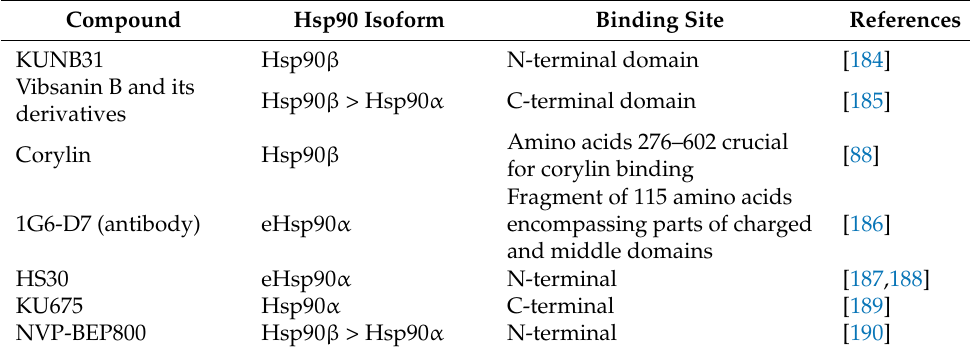
Table 5. Isoform-specific inhibitors of